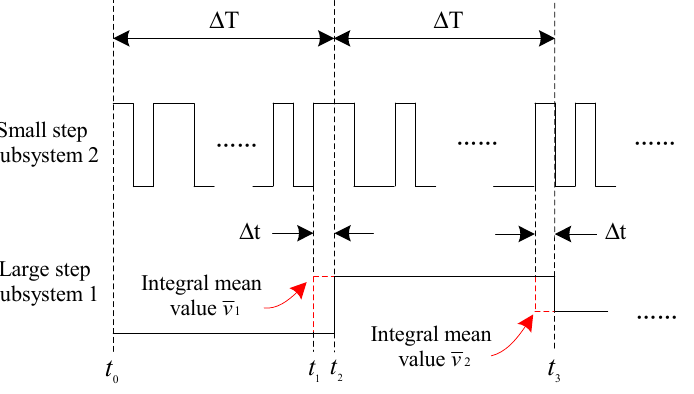
Figure 5. Small-step PWM effect averaging schematic. Subsystem 2 sends v ahead of time, and subsystem 1 uses this value in the next large step for simulation. The above process is repeated in each ∆ T thereafter to obtain the mean value of the small-step effect for subsystem 2, which indirectly reflects the current state of the small-step model. A series of equal-width and unequal-amplitude pulse data is obtained on the large-step side, thus enabling asynchronous data interaction.